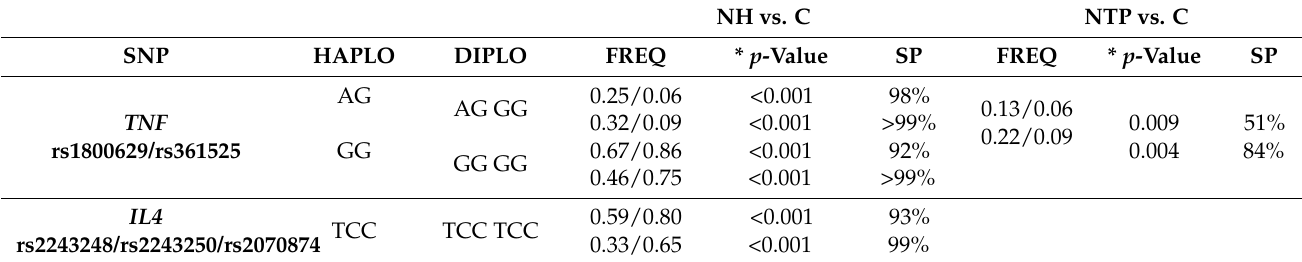
Table 6. Haplotype and diplotype distribution frequencies of TNF , IL4 , and IL10 genes in NSAID hypersensitivity and NSAID-tolerant patients compared to controls.